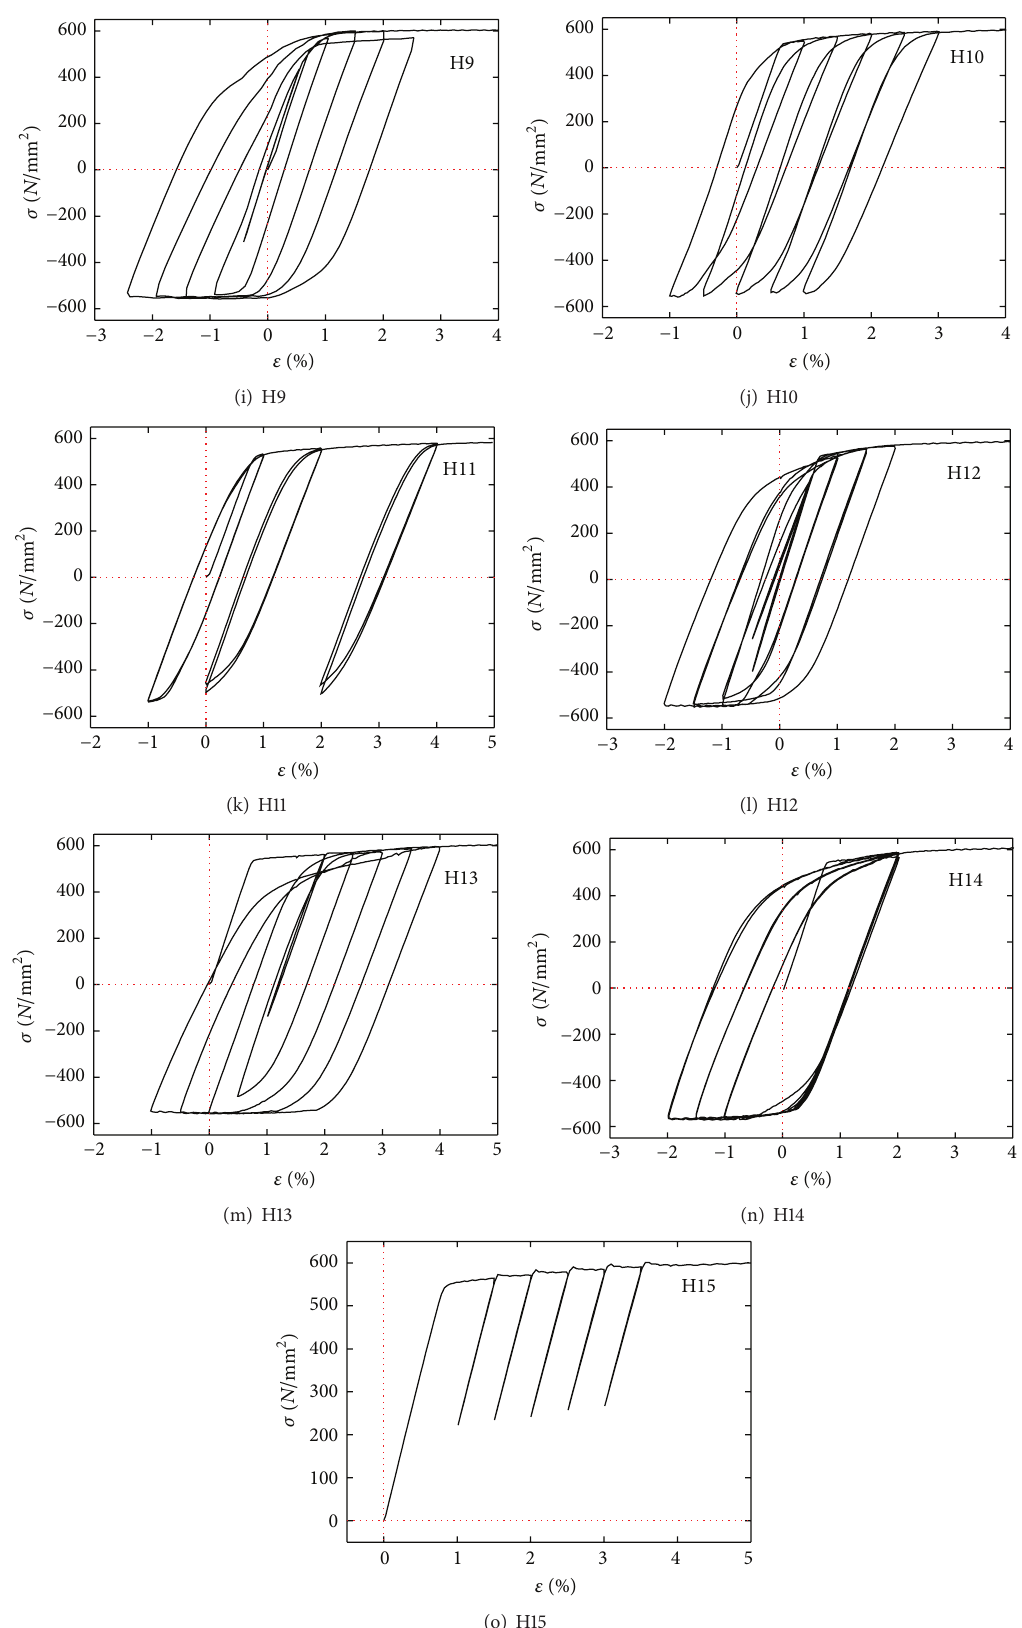
Figure 6: Stress-strain curves of 7A04 HSAA under cyclic